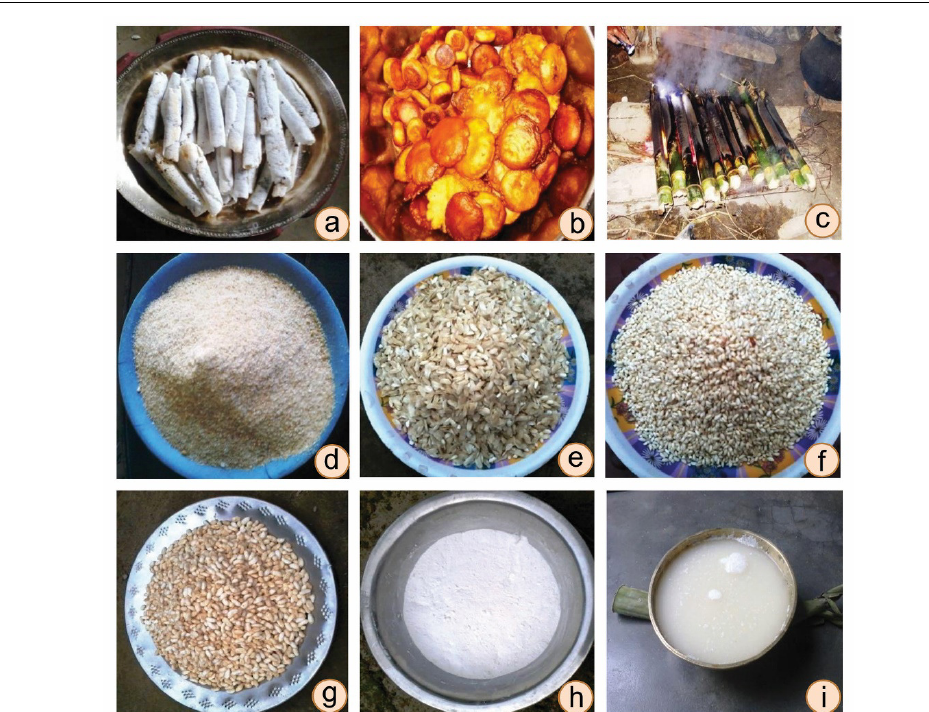
Fig .4. Rice based food and beverages of Lakhimpur, Assam: a. Til pitha, b. Tel pitha, c. Sunga pitha d. Handoh, e. Sira, f. Bora saul, g. Muri, h. Pitha guri, i. Haaz (traditional